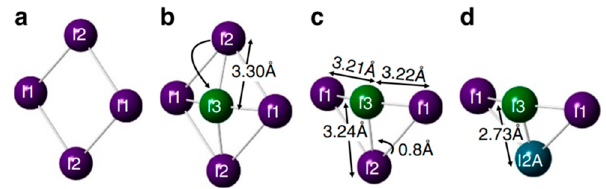
Figure 6. Proposed mechanism for I 2 formation in MAPbI 3 . ( a ) (110) plane of perovskite showing four I − ions. ( b ) Iodine at I2 position moves to interstitial I3 position. ( c ) I3 is now surrounded by three iodine ions at approximately same distances. ( d ) This leads I2 to move to the I2A position, creating a bond and producing a I 2 molecule (bond between I3 and I2A). Reproduced with permission from Nat. Commun. 2017 , 8 , 15152. Reference